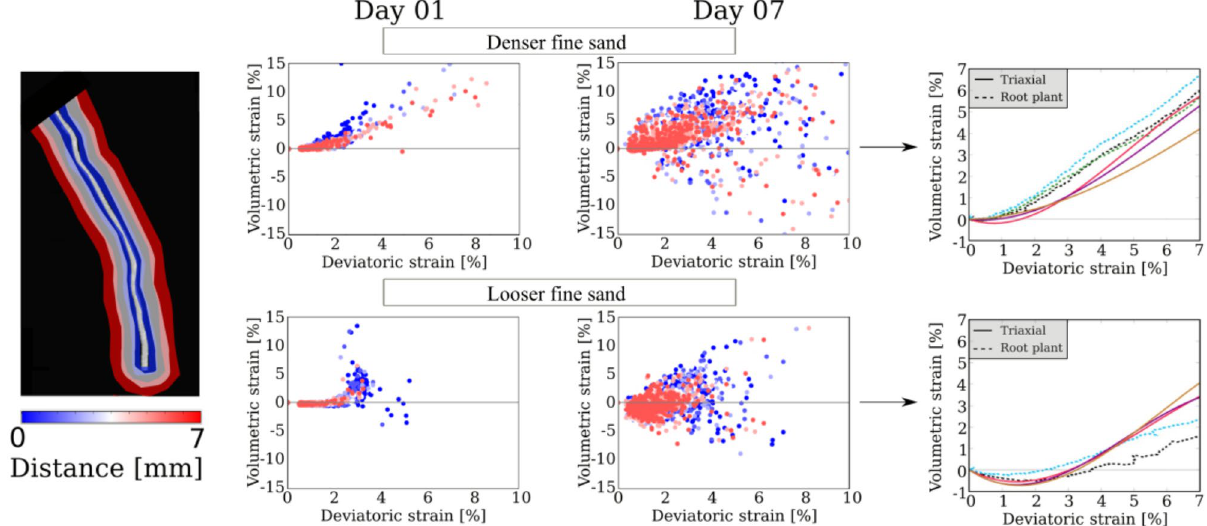
Figure 9. Plots of volumetric strain versus deviatoric strain in the vicinity of the primary root at Day 1 and Day 7. Blue dots (respectively, red dots) refer to points located in the immediate vicinity (respectively, further neighbourhood) of the root, i.e., in the blue zone (respectively, red zone) in the left picture. On the right hand-side, the interpolation line of the clusters (continuous line) are compared to strains measured during compression triaxial tests 27 (dashed